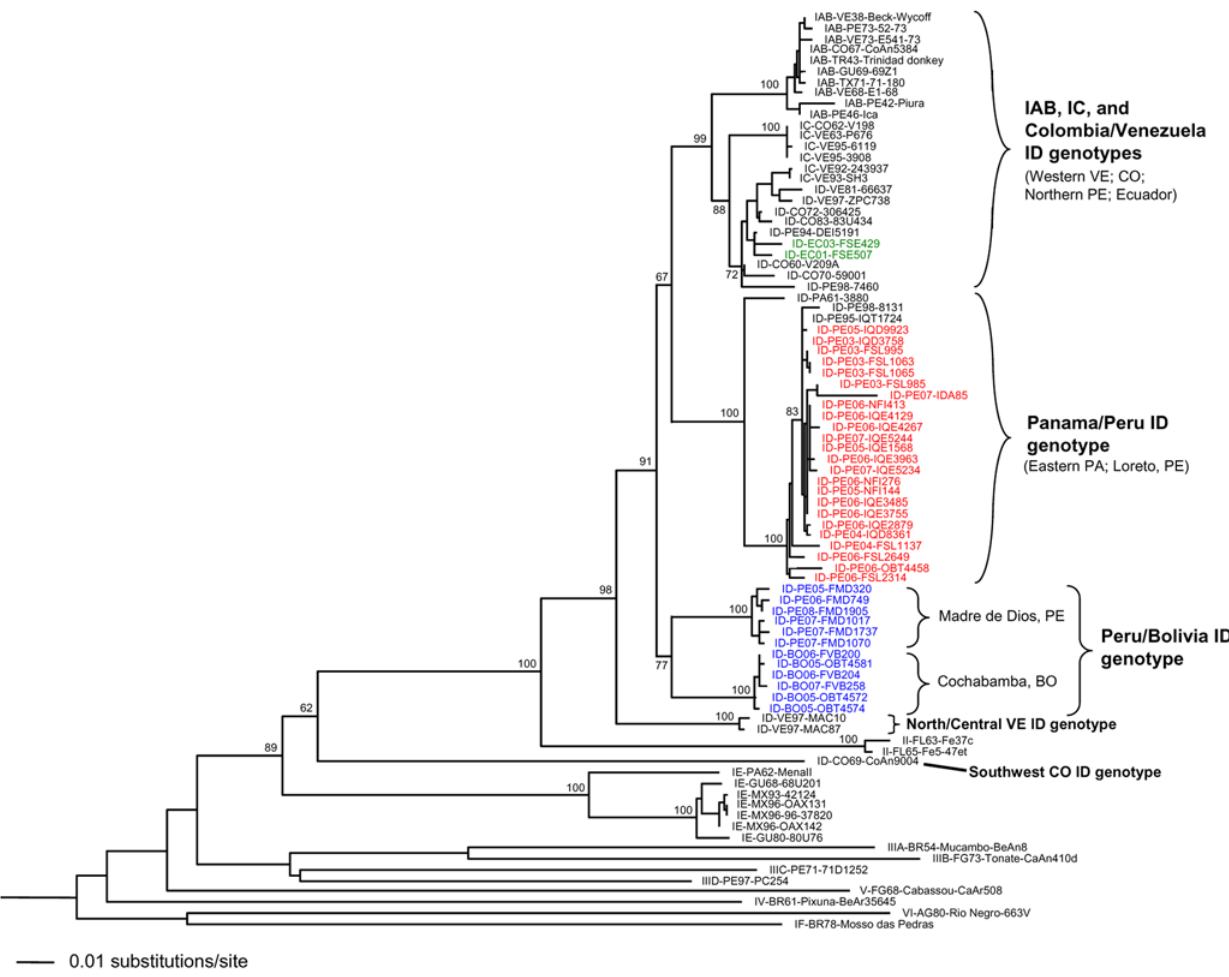
Figure 2. Neighbor joining phylogenetic tree of the Venezuelan equine encephalitis virus (VEEV) complex. The tree was derived from partial envelope glycoprotein precursor (PE2) gene sequences of recent VEEV isolates from Ecuador (green), Peru (red), and Bolivia (blue) and previously published homologous sequences, using the neighbor joining program implemented in PAUP* version 4.0 [31]. The tree was rooted using an outgroup comprised of 4 major lineages of eastern equine encephalitis virus [32]; the outgroup has been removed to improve resolution of the figure. Virus strains are labeled by VEE complex subtype, abbreviated country name and year of isolation (last two digits of year only), followed by the strain or code designation. The abbreviated country names are as follows: PA, Panama; GU, Guatemala; MX, Mexico; FL, Florida; TX, Texas; TR, Trinidad; FG, French Guiana; VE, Venezuela; CO, Colombia; BR, Brazil; AG, Argentina; PE, Peru; EC, Ecuador; BO, Bolivia. Numbers indicate bootstrap values for the clades to the right. Trees generated using maximum parsimony and maximum likelihood methods had identical topologies except for some groupings between subtypes III and V.